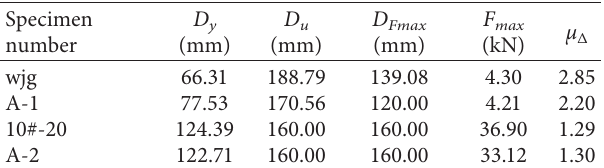
Figure 14: Skeleton curve of specimen A-1 and model wjg. Table 4: Comparison of seismic performance indexes of specimen and model.